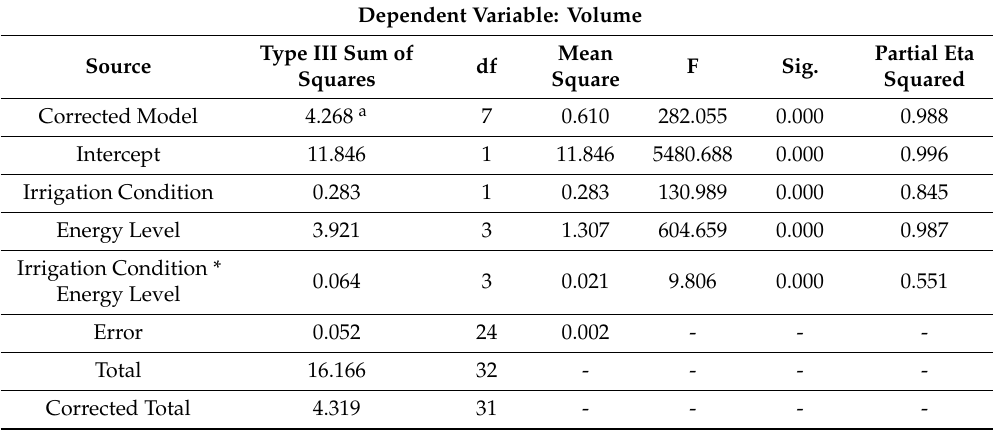
Table A4. Tests of Between-Subjects E ff ects.